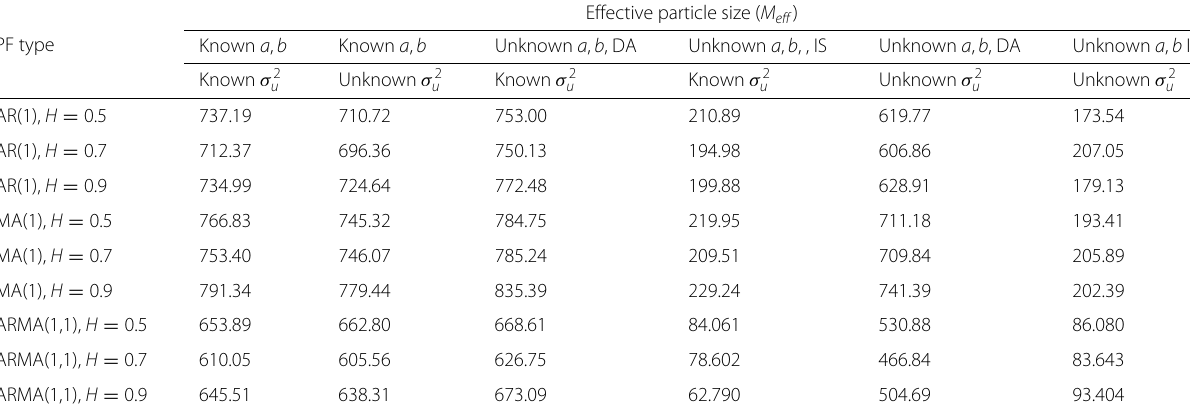
Table 3 Efficient particle size M eff of the proposed SMC methods for different ARMA models with fGn PF